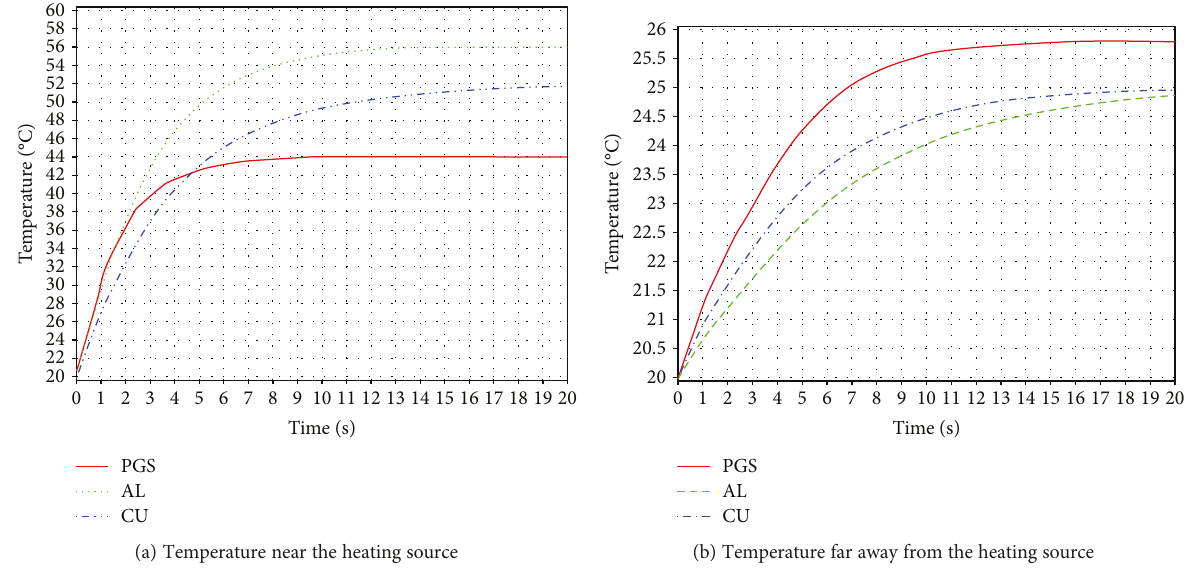
Figure 4: Comparison of the di ff erent materials.